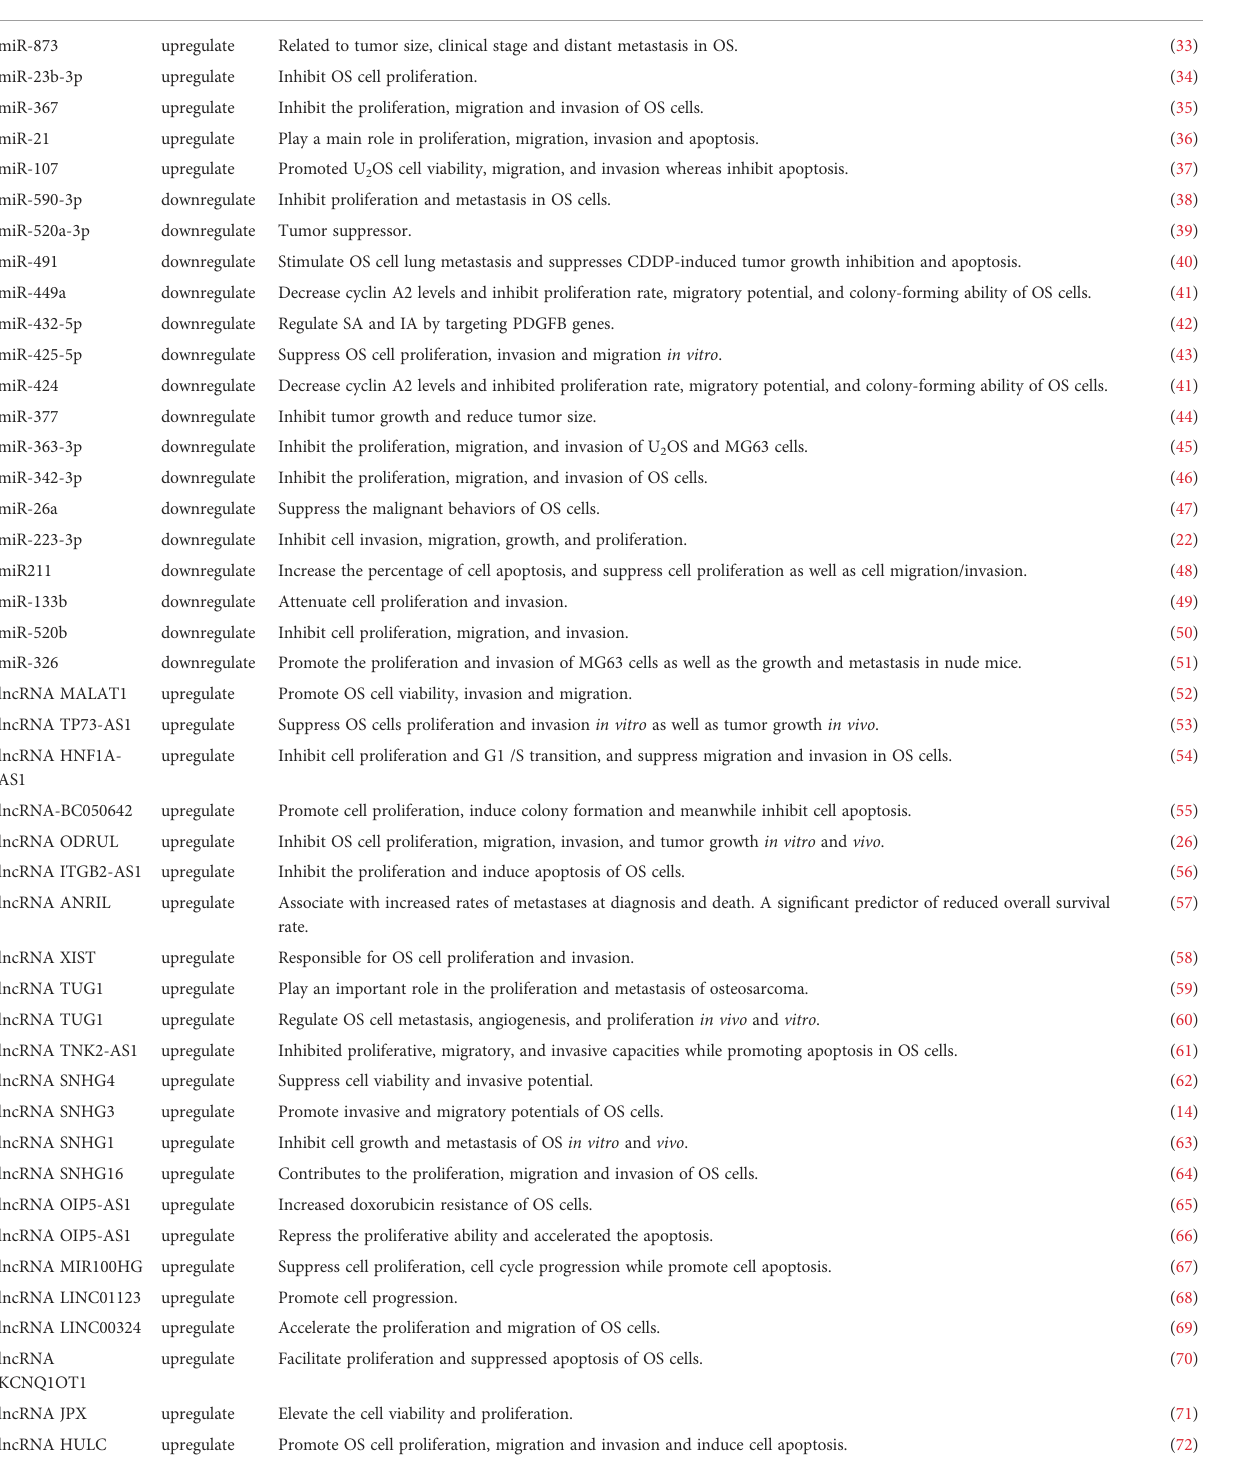
TABLE 1 Regulation of miRNAs, lncRNAs and circRNAs in OS cells. Non-coding